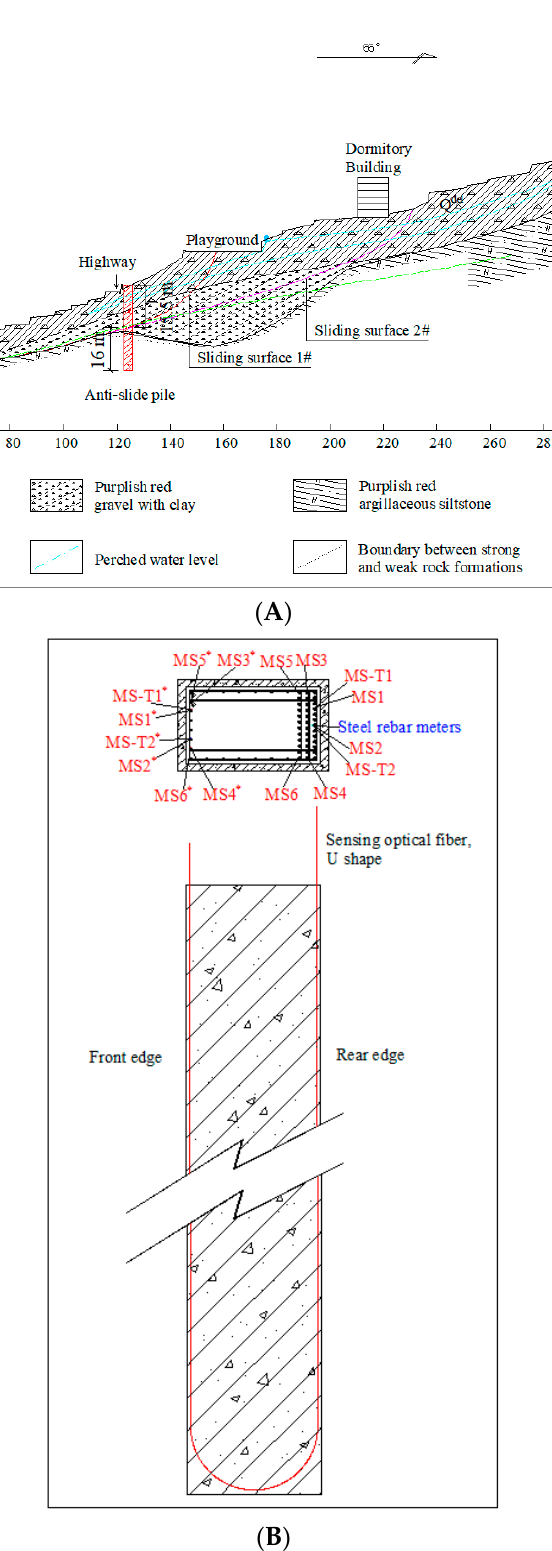
Figure 3. Vertical profile diagram ( Ⅰ - Ⅰ ) of landslide engineering and layout diagram of sensors and anti-slide pile. ( A ) Vertical profile diagram (I-I) of landslide engineering and anti-slide pile; ( B ) Layout diagram of optical fiber and steel rebar meters.